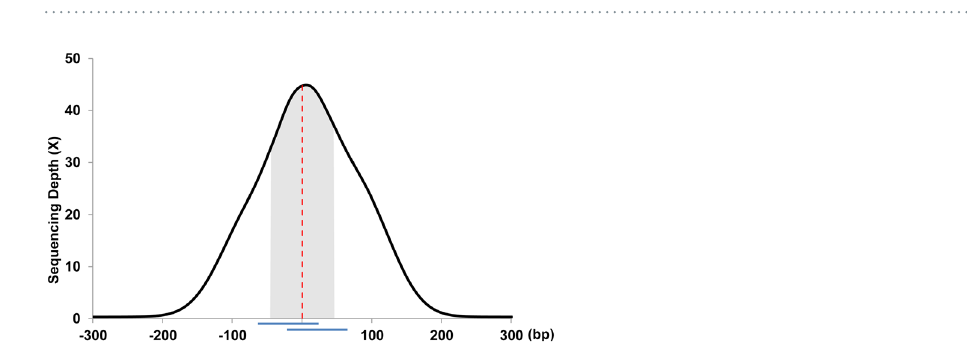
Table 2. Detailed depth description of different type of